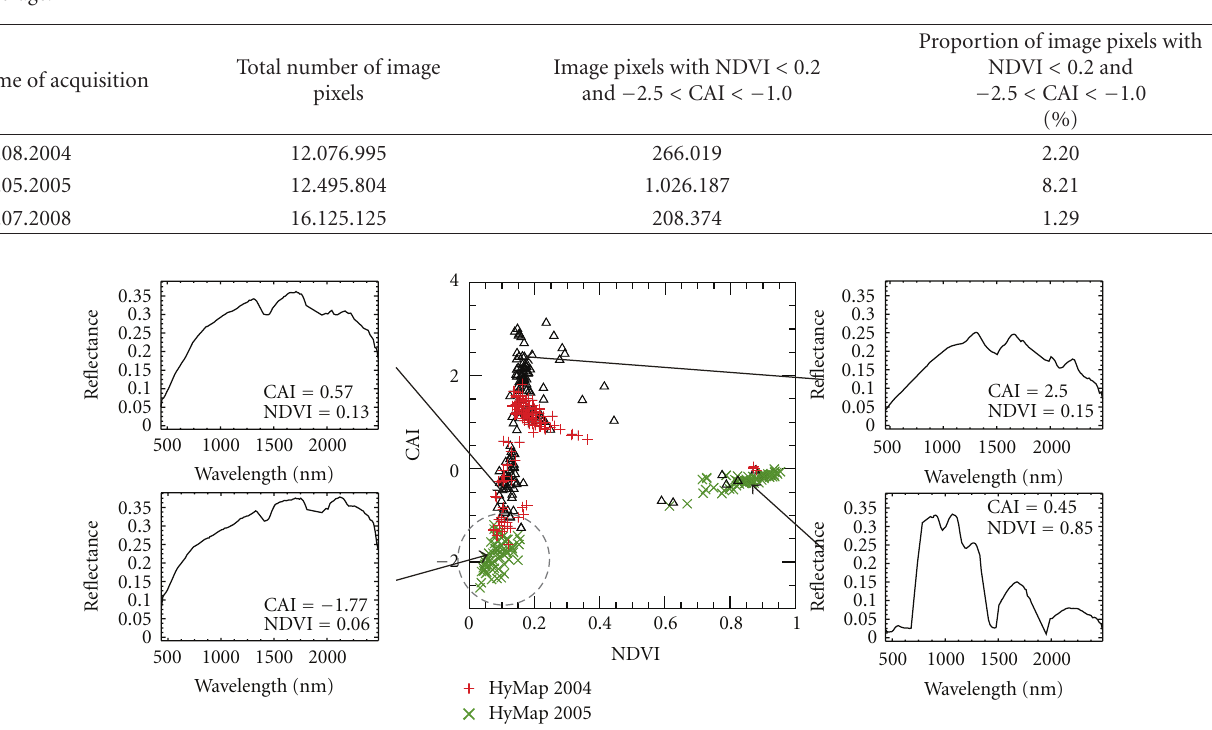
Table 3: Area free of vegetation in the HyMap images from 2004, 2005, and 2008 given in absolute values and percentage of the total image coverage.